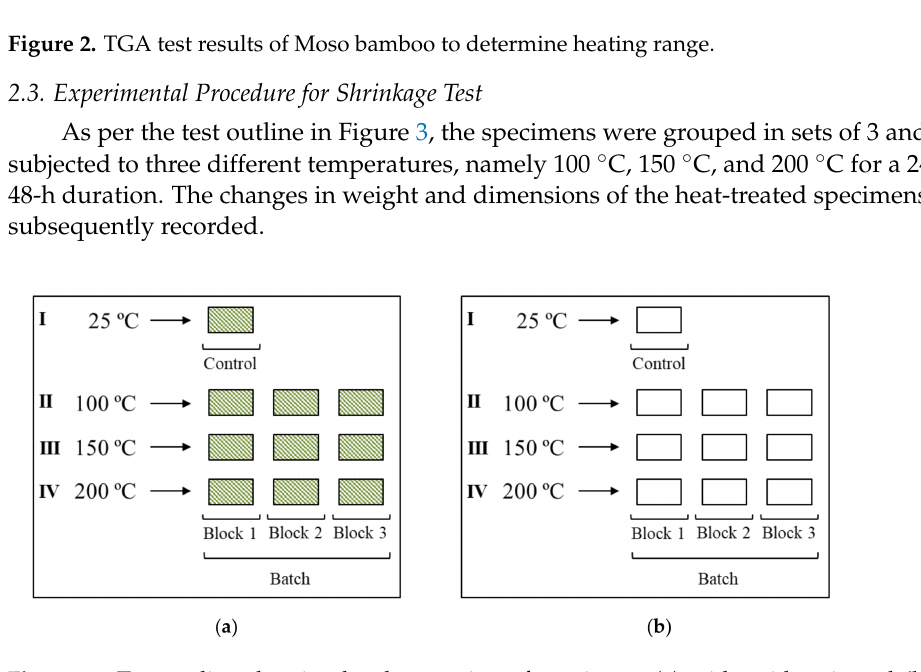
Figure 3. Test outline showing batch grouping of specimen: ( a ) with epidermis and ( b ) with planed